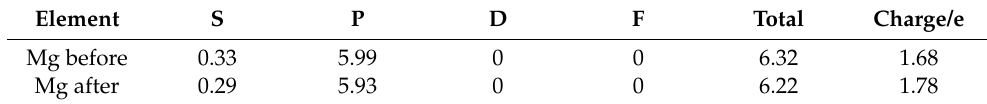
Table 6. Mulliken charges of Mg adsorbed on the (001) surface of Mt.